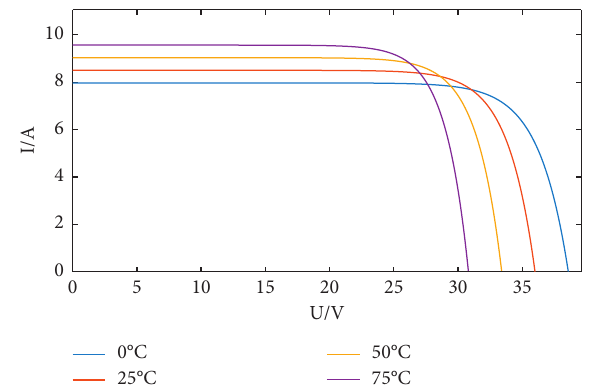
Figure 4: I-U output curve of the photovoltaic cell when tem- perature changes.